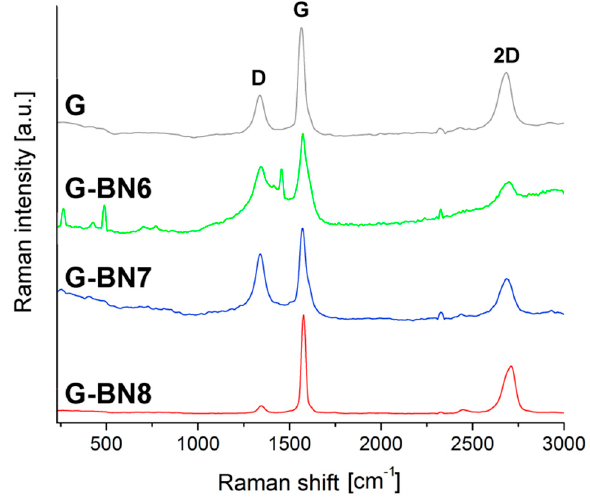
Figure 8. Raman spectra of unmodified graphene and samples after its functionalization with fullerene derivatives BN6 , BN7 and BN8 .